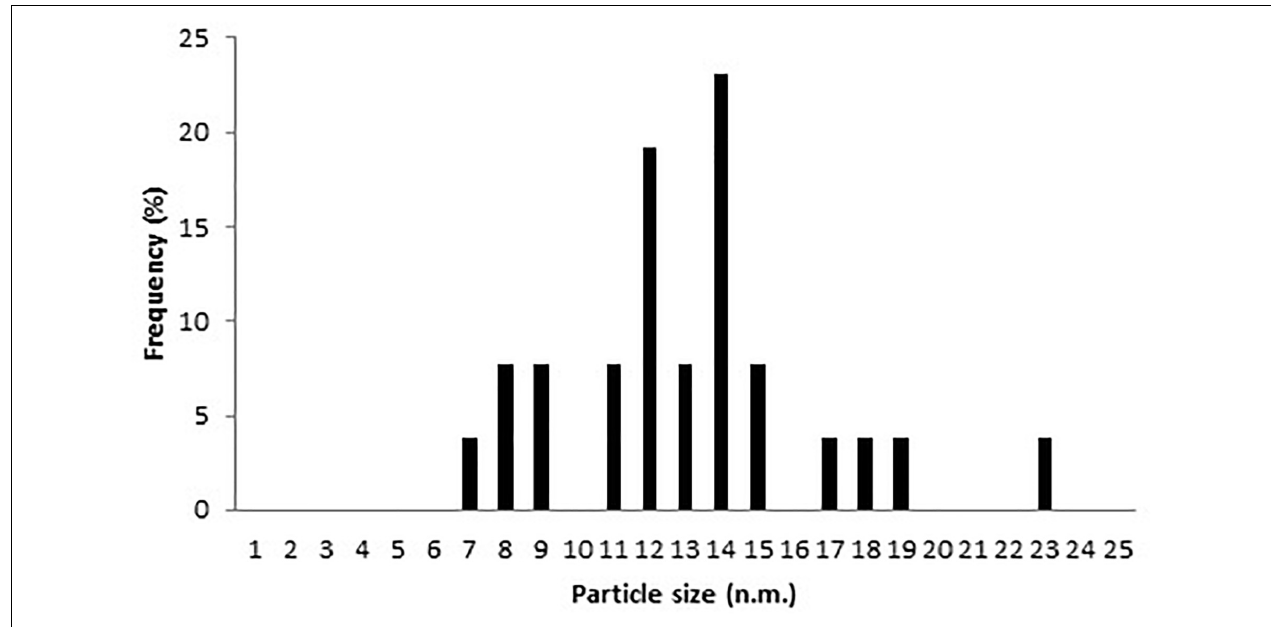
FIGURE 5 | Nanoparticles size distribution of AgNPs synthesized by A. terreus BA6.